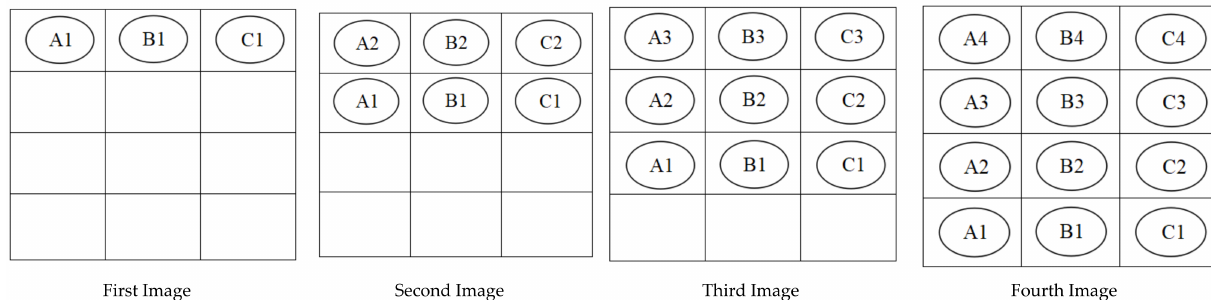
Figure 5. Online image acquisition process of preserved